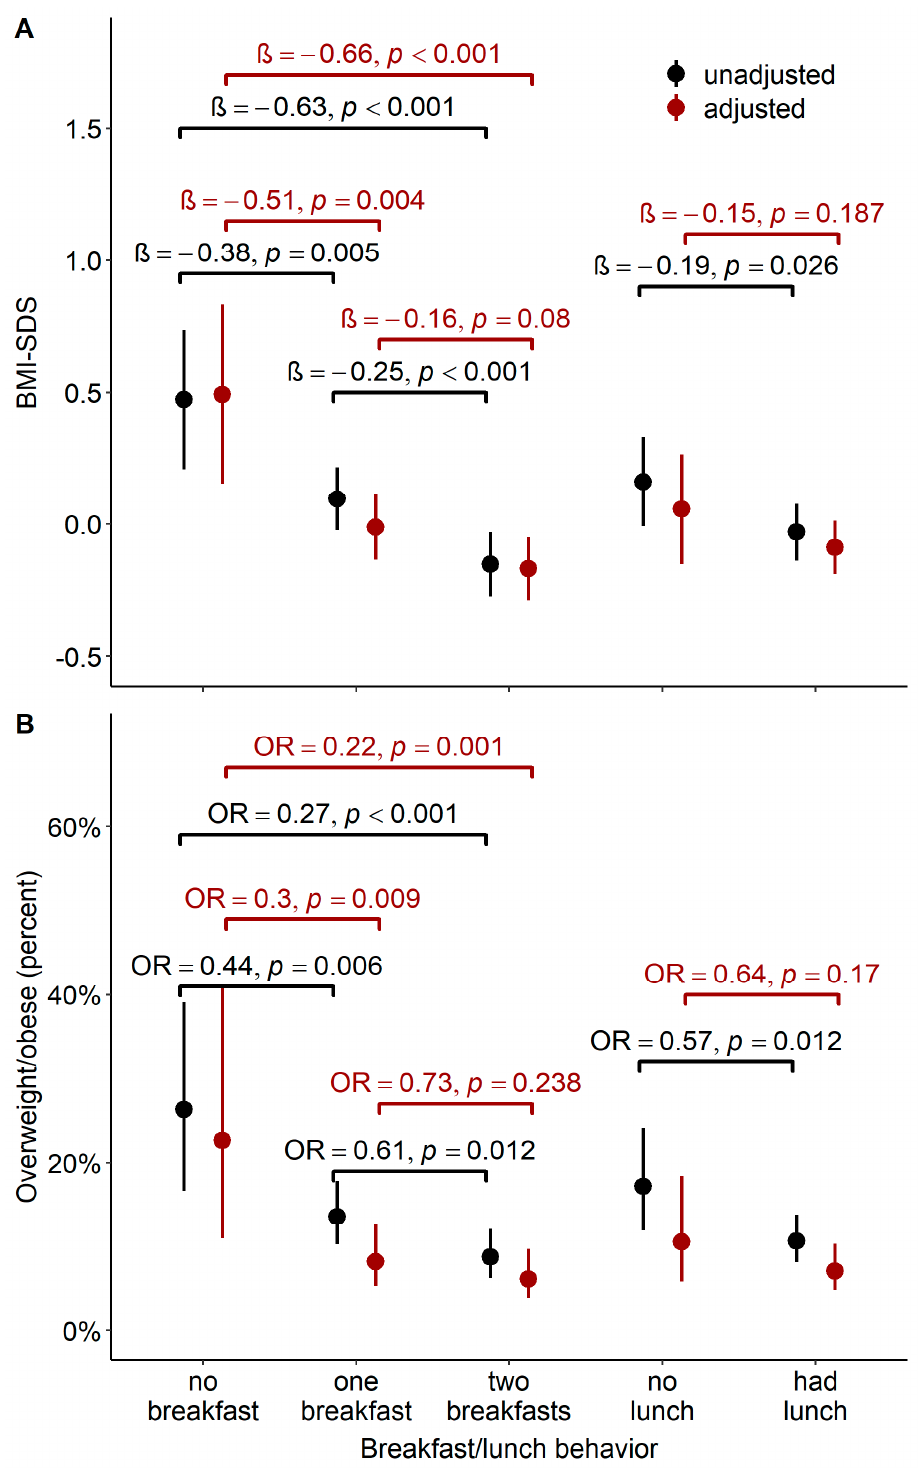
Figure 2. Association of different eating habits with mean BMI-SDS/the likelihood of being overweight. ( A ) . Mean BMI-SDS (incl. 95% CI) for children with different breakfast/lunch behavior: Based on the simple hierarchical regression analysis, children with different eating habits also differed in their mean BMI-SDS (black). Most of the associations persisted after adjustment (red). ( B ) . The likelihood of being overweight (incl. 95% CI) for children with different breakfast/lunch behavior: based on the simple hierarchical logistic regression analysis, children with different eating habits also differed in their likelihood of being overweight (black). The difference in the likelihood between children having and not having breakfast remained statistically significant after adjustment